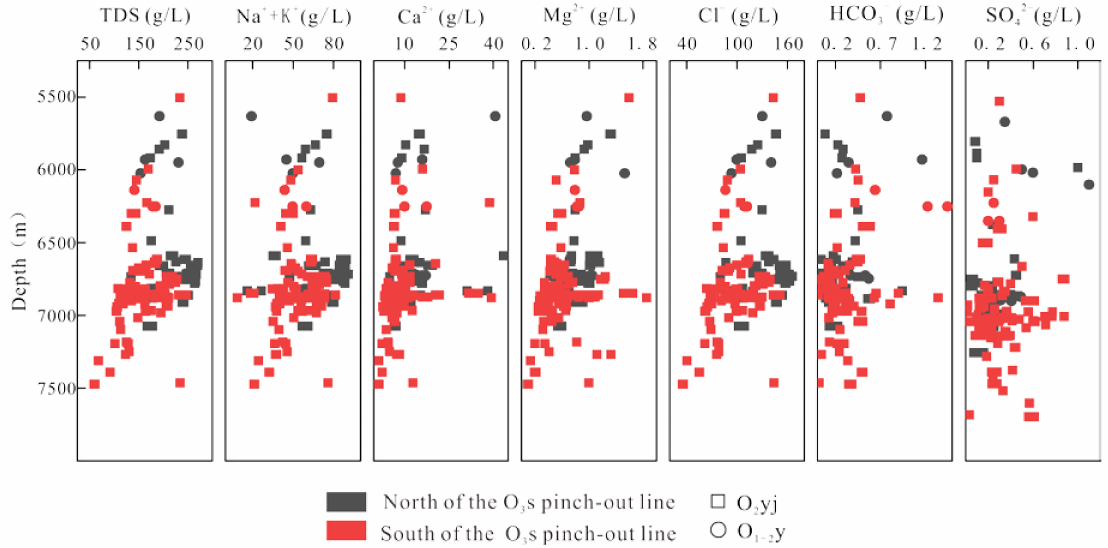
Figure 2. The ion concertation distribution of Ordovician formation water in the Halahatang depres- sion with depth (The raw data sourced from Tarim Oil Field Company). A weak negative correlation between the depth and TDS. (Depth above 6500 m: depth = − 5.16 TDS + 6999.30 R 2 = 0.49; Depth below 6500 m: depth = − 2.08 TDS + 7234.50 R 2 =